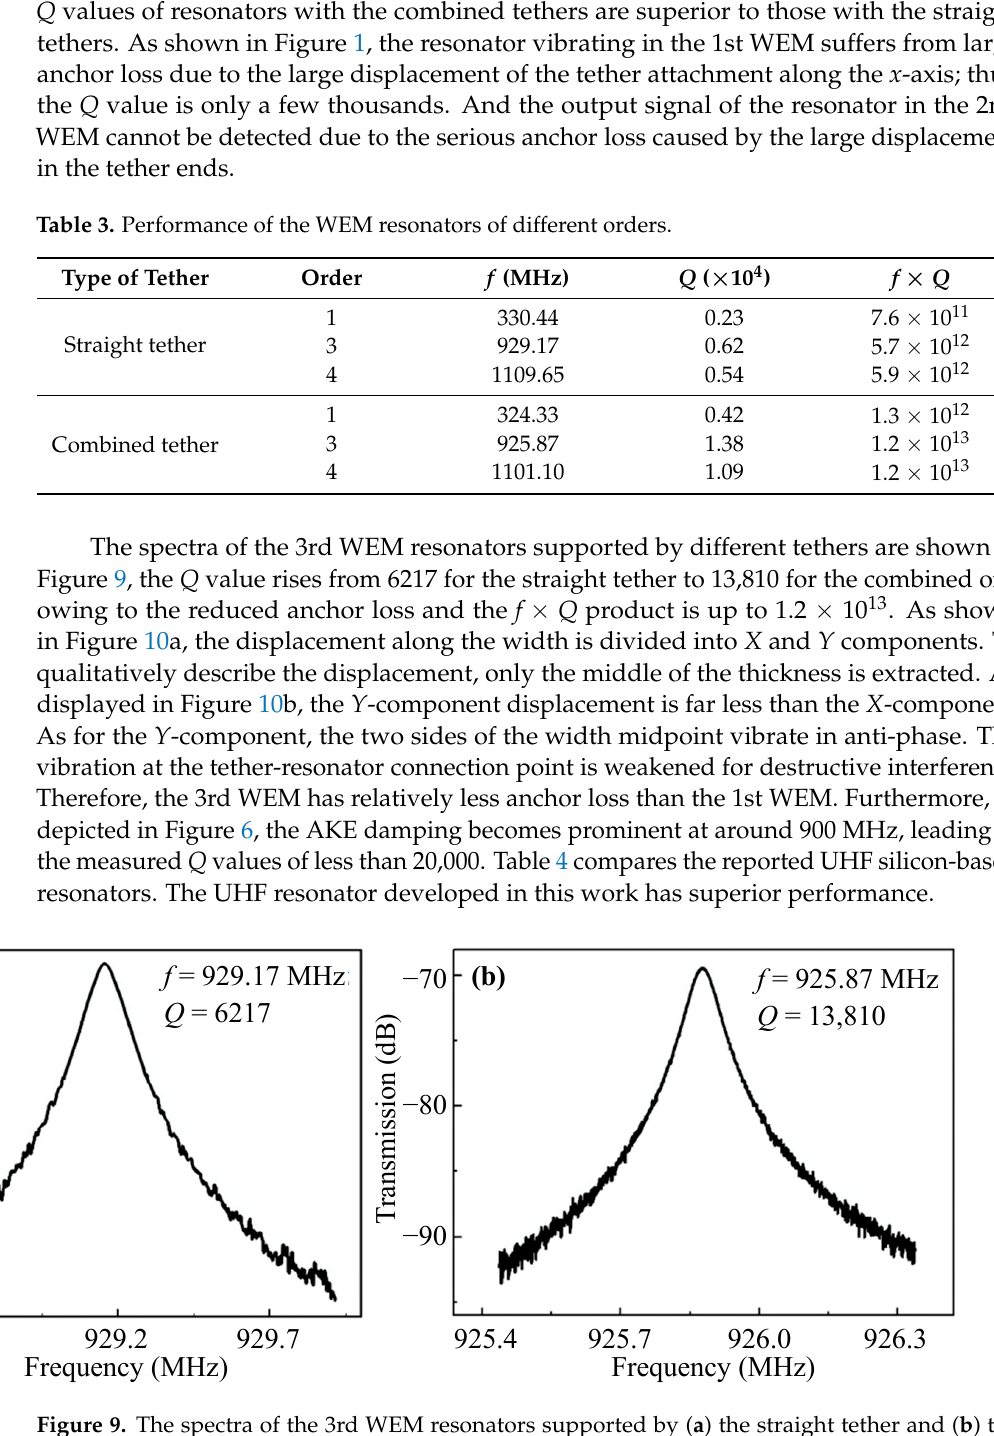
14 Figure 10. The top and side views of the 3rd WEM mode shape ( a ) and the normalized displace- ment of the 3rd WEM vs. the coordinates along the width ( b ). Table 4. The f × Q product comparison between the reported UHF silicon-based resonators and this work. References